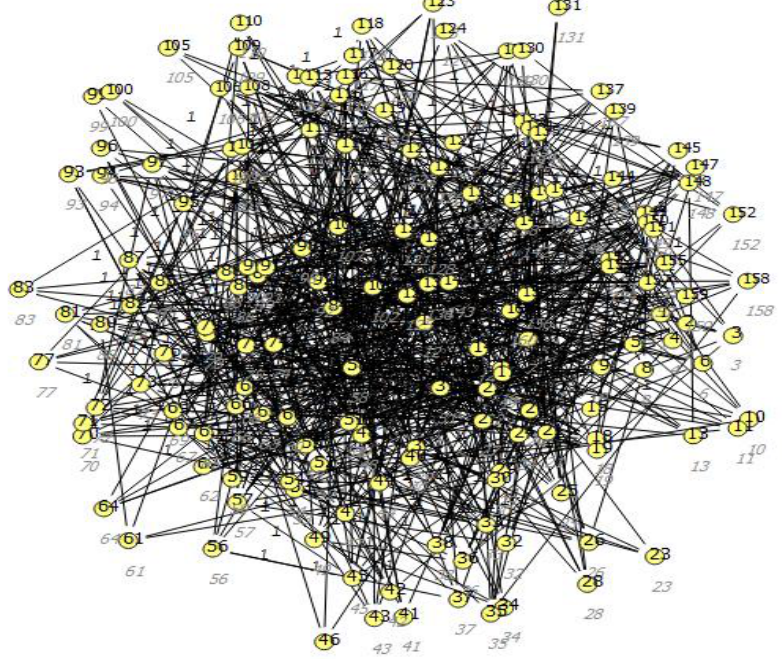
Figure 19. Ordered rule-based dependency according to the Kamada – Kawai model.